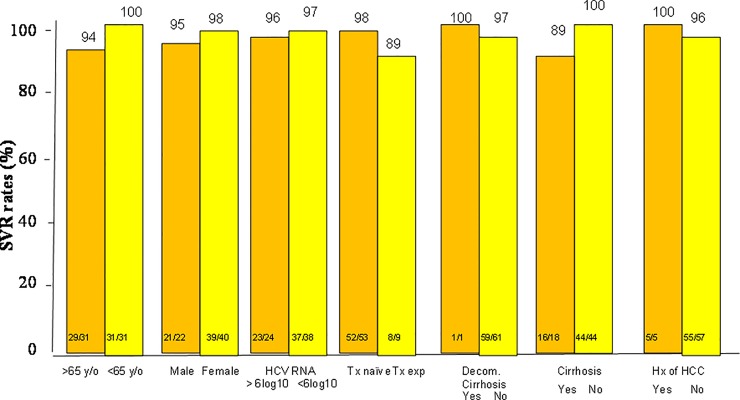
Subgroup analysis of the sustained virologocal response (SVR) rates in patients who received SOF/DCV/RBV regimen.SOF: sofosbuvir, RBV: ribavirin, DCV: daclatasvir.